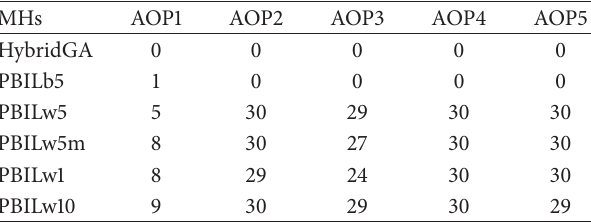
Table 6: Number of worst cases found by the